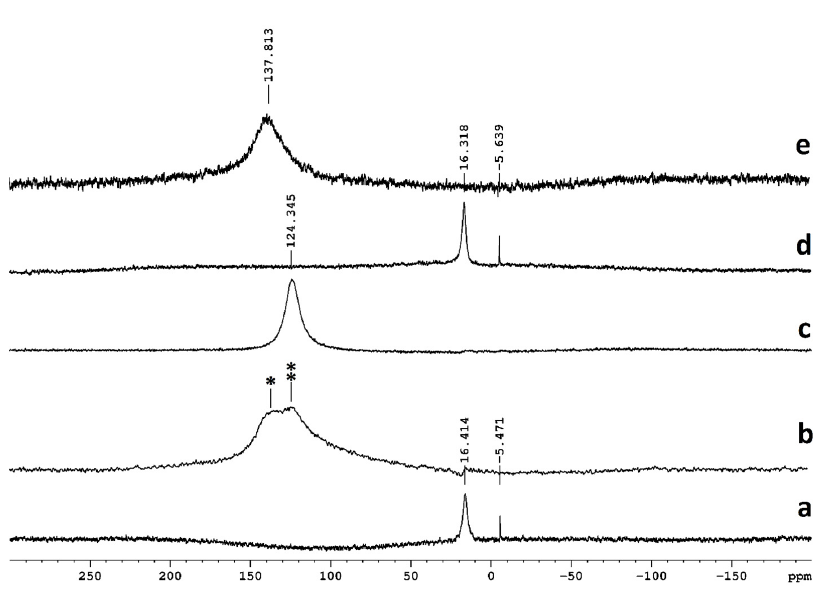
Figure 9. 95 Mo NMR data describing Mo8 and V10 reaction: ( a ) 70 mg Mo8 (300 µ L DMSO-d6) + 55 mg V10 (300 µ L DMSO- d 6 ) room temperature; ( b ) 70 mg Mo8 (300 µ L DMSO-d6) + 22 mg V10 (300 µ L DMSO- d 6 ), after 10 min at 60 ◦ C; ( c ) 70 mg (Bu 4 N) 2 [Mo 6 O 19 ] in 600 µ L DMSO- d 6 ; ( d ) 70 mg Mo8 in 600 µ L DMSO- d 6 ; ( e ) 70 mg of (Bu 4 N) 3 Na[V 2 Mo 4 O 19 ] in 600 µ L DMSO- d 6 * Chemical shift (CS) = 137.4301 ppm, ** CS = 123.3993 ppm.